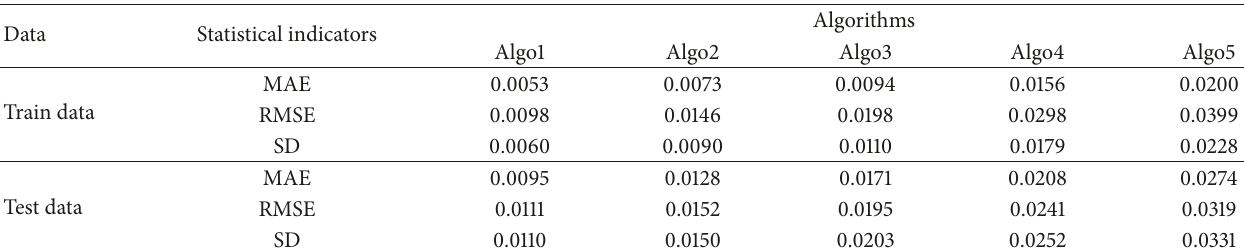
Table 4: Results of sample prediction error.